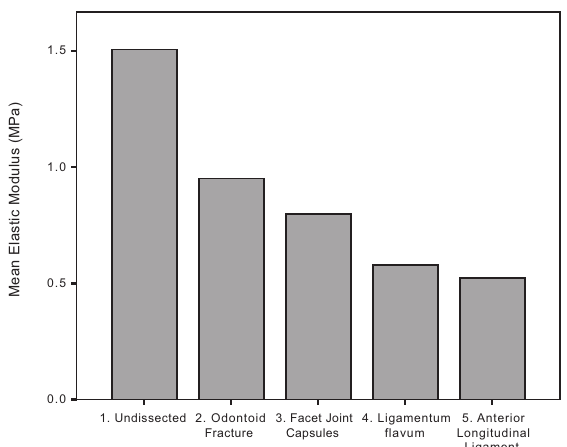
Figure 5. Graph showing successive reduction in the stiffness of the C1-C2 complex after successive division of the structures. Mean elastic modulus (MPa) displayed on y -axis. On x -axis: 1. Undis- sected specimen; 2. Specimen after fracture of the odontoid process; 3. Division of facet joint capsules; 4. Division of ligamentum flavum; 5. Division of Anterior Longitudinal Ligament.